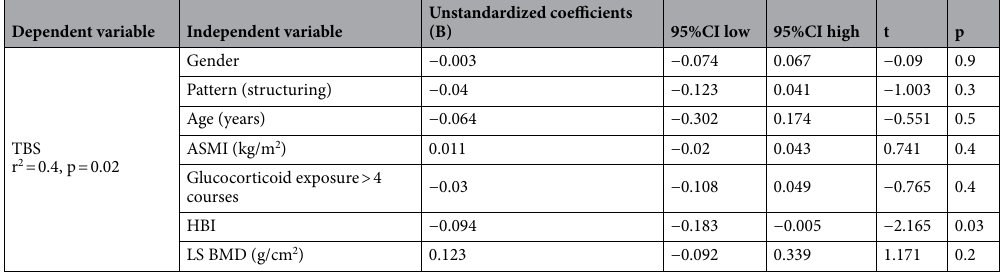
Table 4. Determinants of TBS values in CD patients. TBS trabecular bone score, ASMI appendicular skeletal mass index, HBI Harvey Bradshaw Index, LS BMD lumbar spine bone mineral